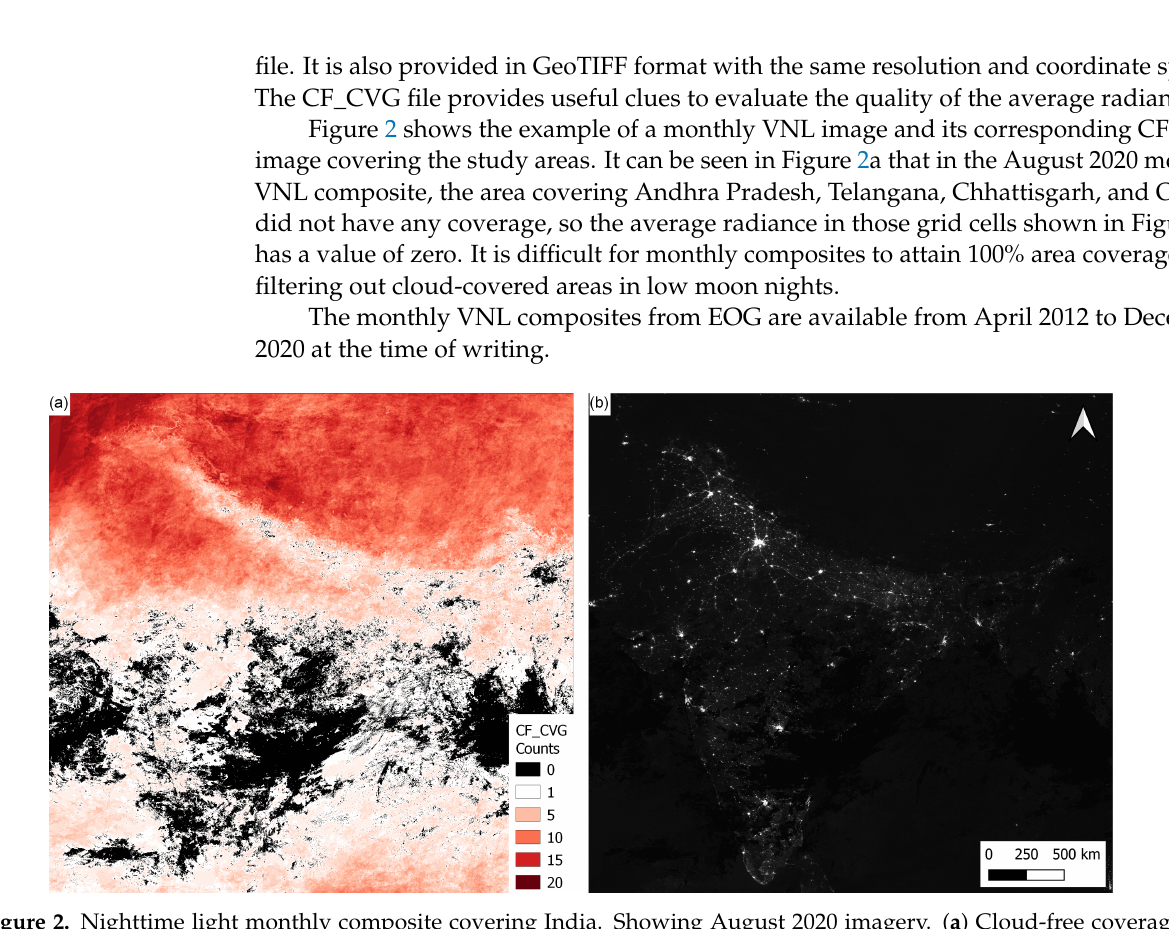
Figure 2. Nighttime light monthly composite covering India. Showing August 2020 imagery. ( a ) Cloud-free coverage (CF_CVG) image. ( b ) Average radiance